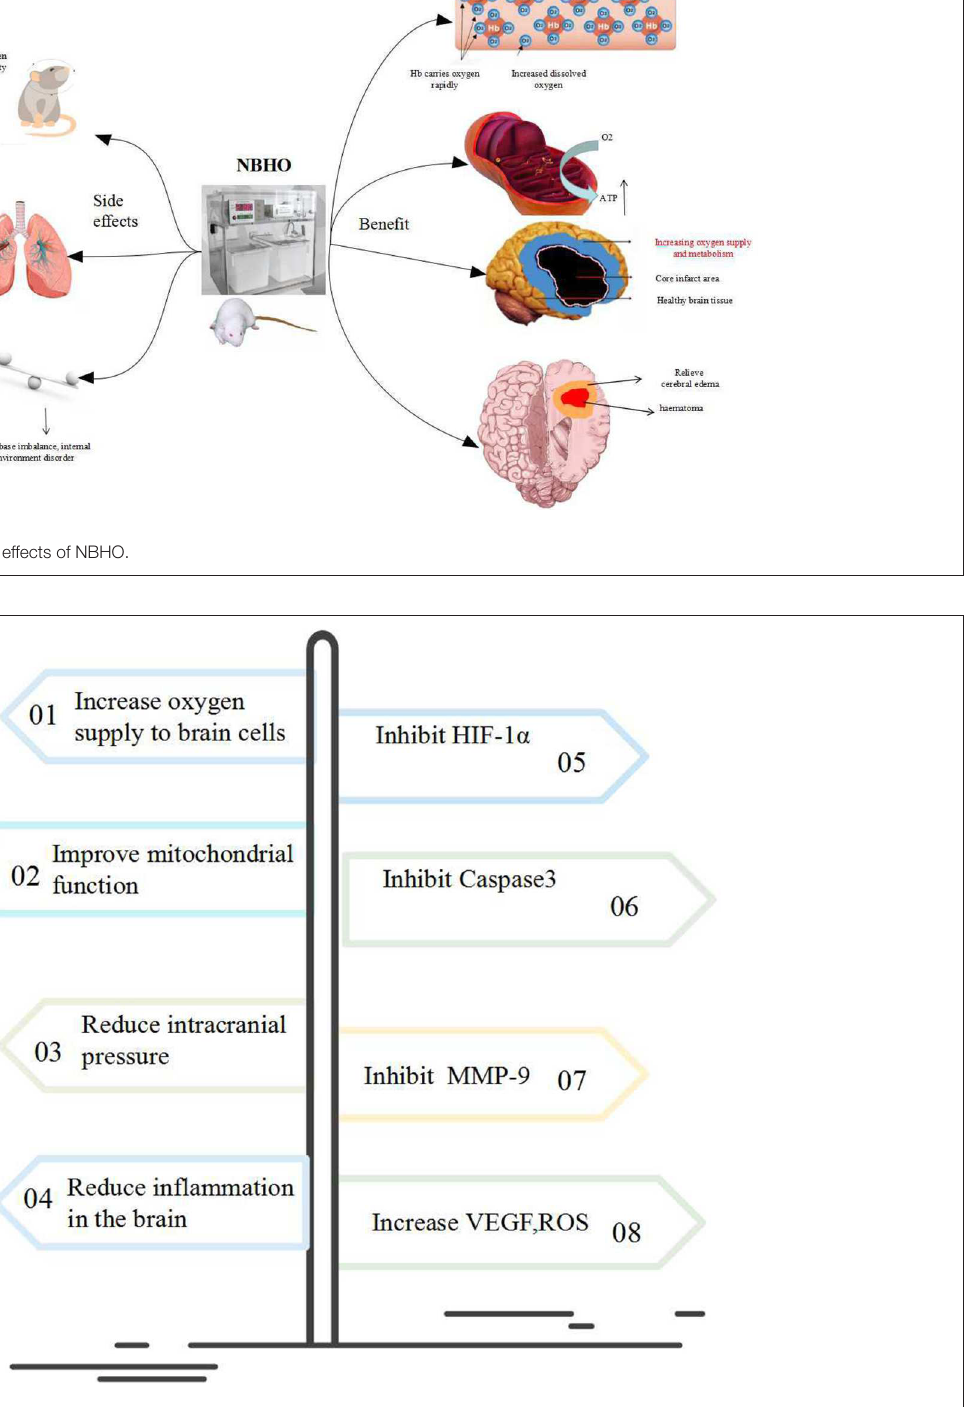
FIGURE 2 | Possible mechanisms of NBHO in brain